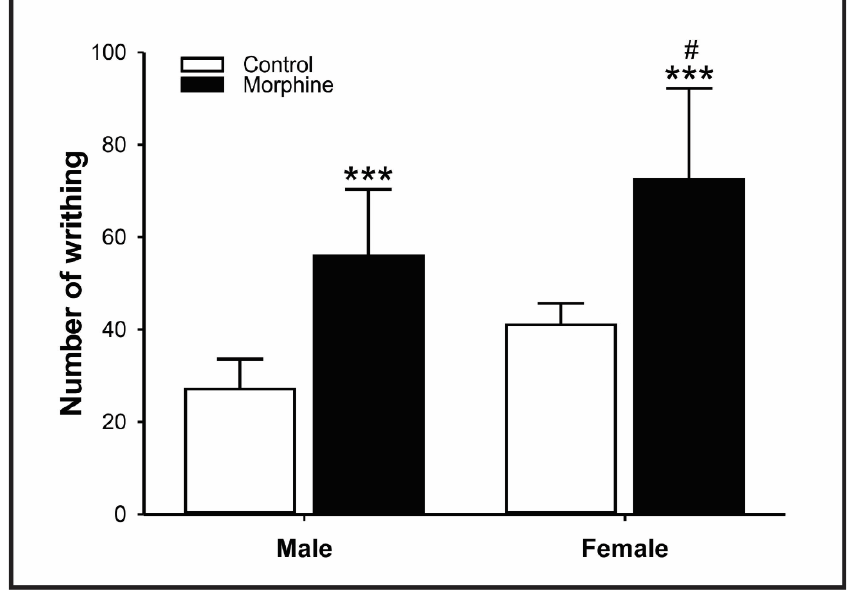
Figure 6. Effect of morphine treatment (10 mg/kg/day) during pregnancy and lactation on mice offspring number of writhing acetic acid ‐ induced. Results expressed as mean ± S.D.M. (male control = 6; female control = 6; male morphine = 8; female morphine = 10). *** p < 0.001 morphine vs.